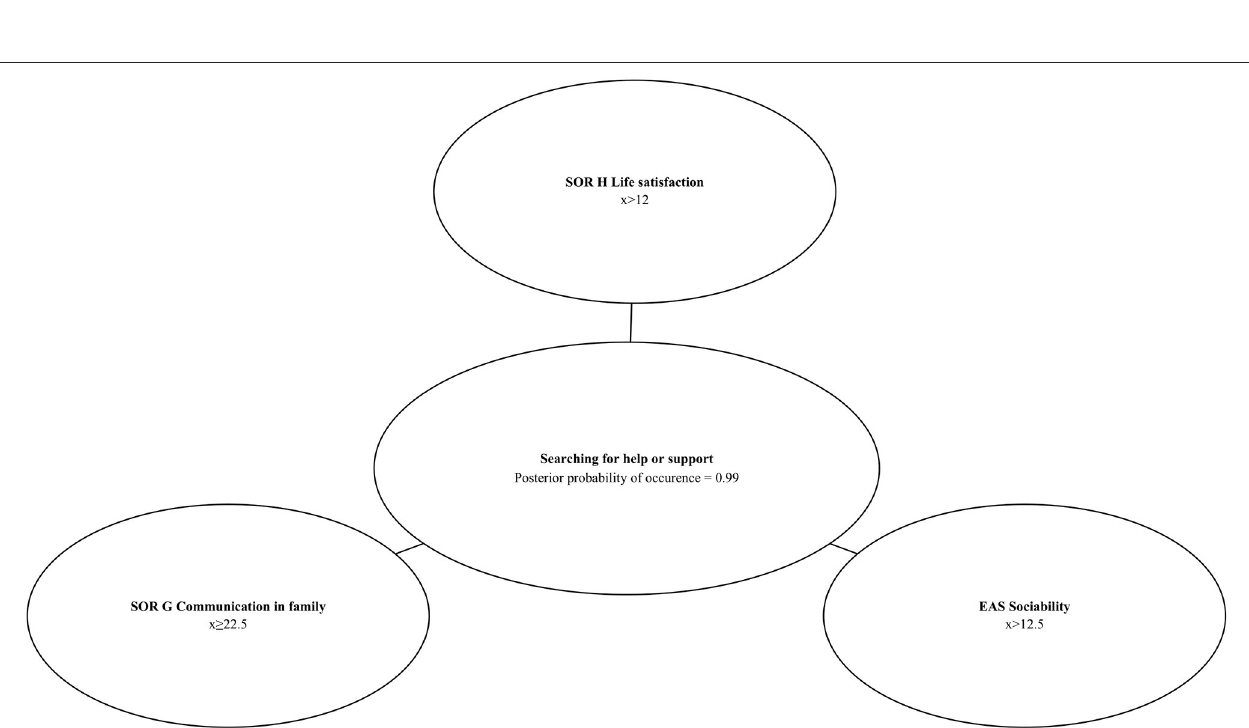
FIGURE 6 | Bayesian network–high posteriori conditional probability of searching for help or support.